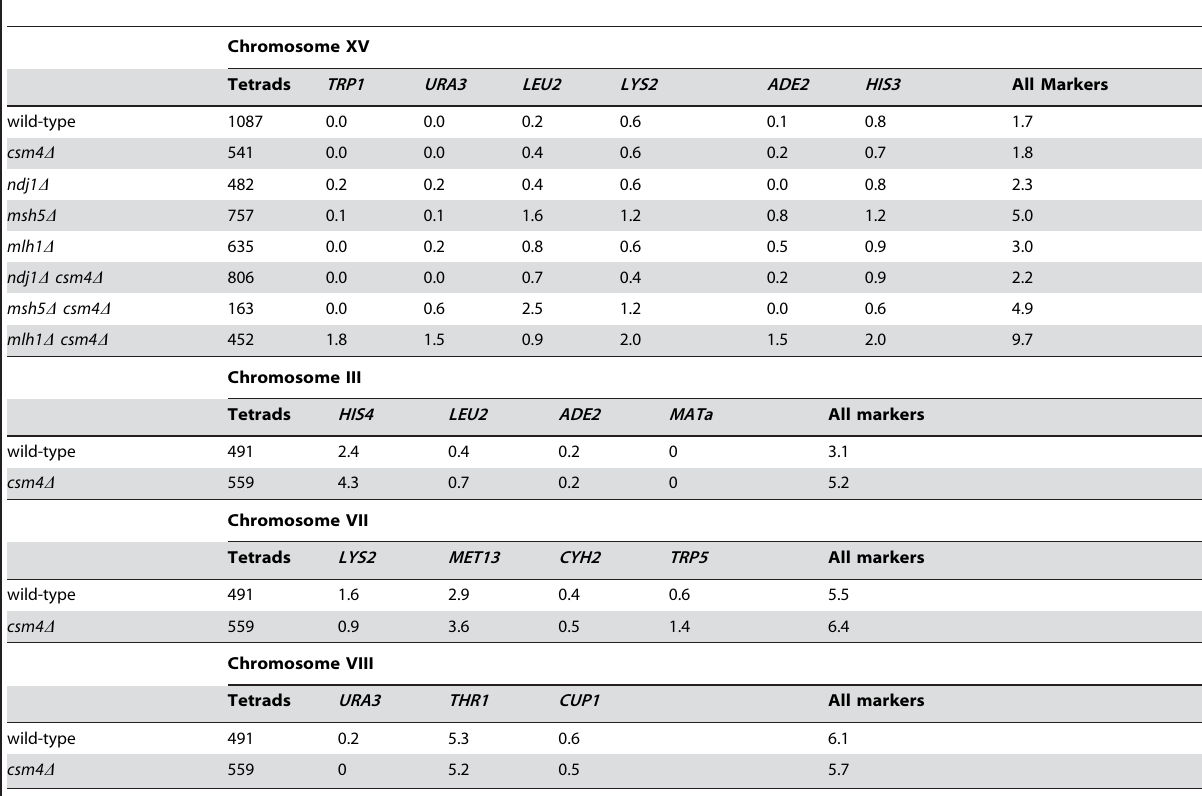
Table 3. csm4 D does not significantly affect the percentage of non-mendelian segregation events observed in